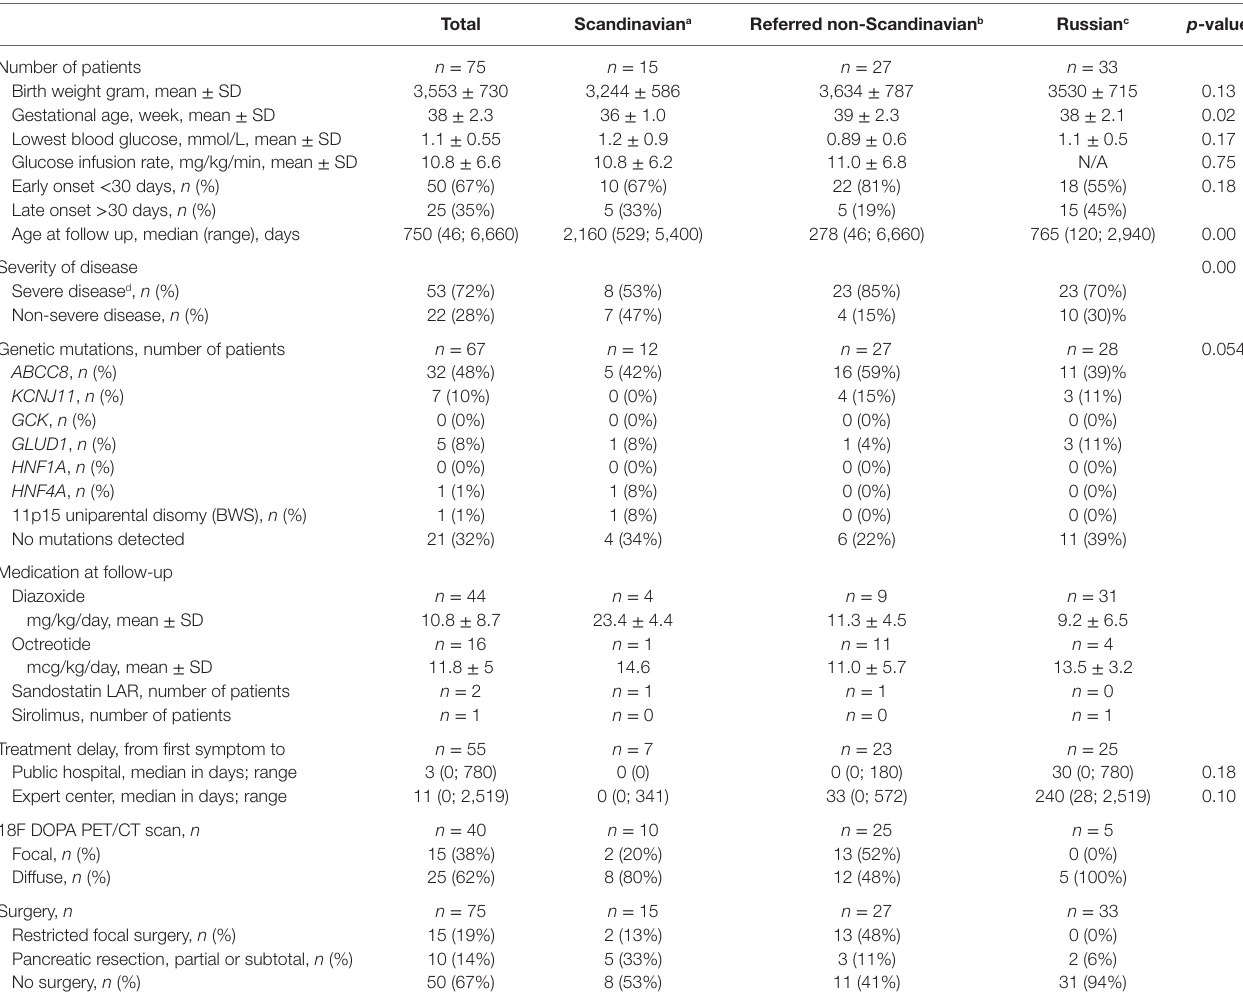
TaBle 1 | Patient